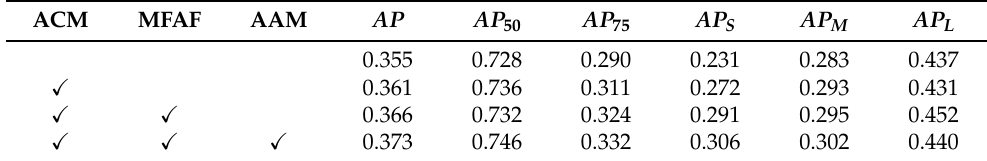
Table 2. The effects of proposed